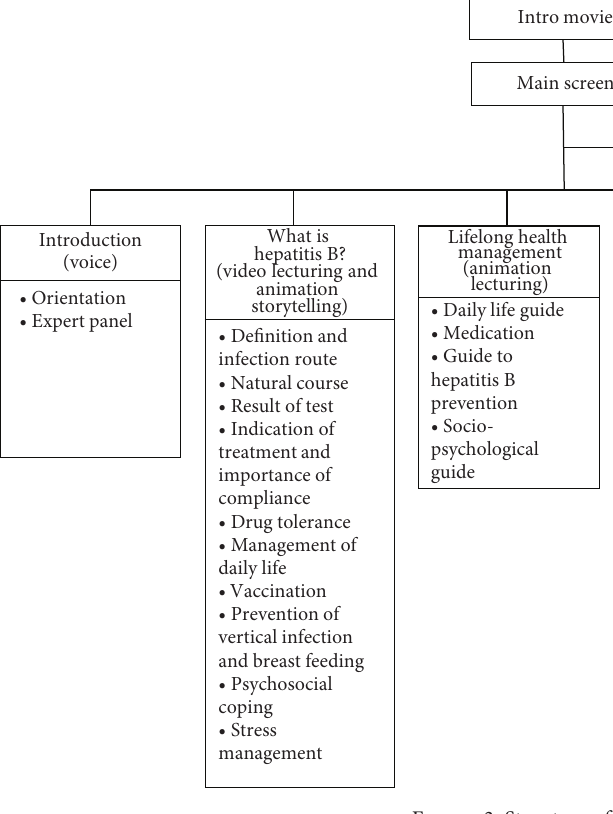
F 3: Structure of the online